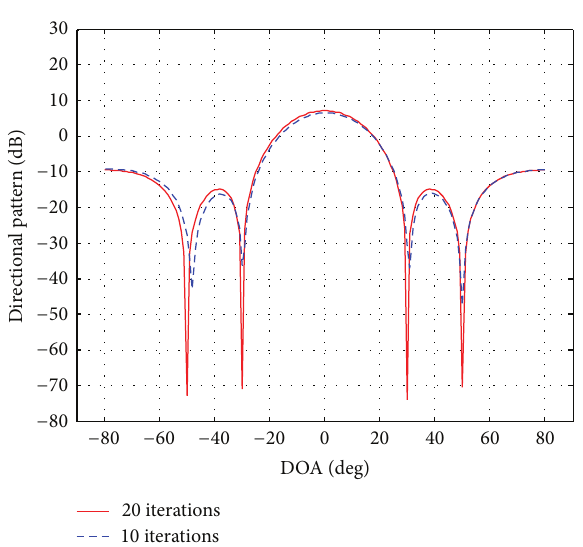
Figure 5: Power response for two users at 0 and 10 interference sources at 50 ∘ , − 50 ∘ , 30 ∘ , and − 30 ∘ with DM-AIS after 10 and 20 iterations.